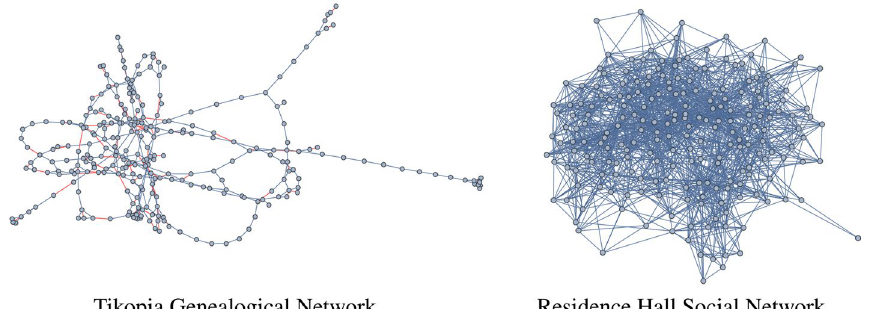
Fig. 1 Left: The largest connected component of the Tikopia genealogical network consisting of 288 individuals from the island of Tikopia in Polynesia from the year 1930 to 2008, is shown (https:// www. kinso urces. net/ brows er/ datas ets. xhtml). Parent-child edges are shown in blue and union edges are shown in red. Right: The largest connected component of the Residence Hall social network consisting of 217 individuals and their friendships from the Australian National University campus is shown (Residence 2022)